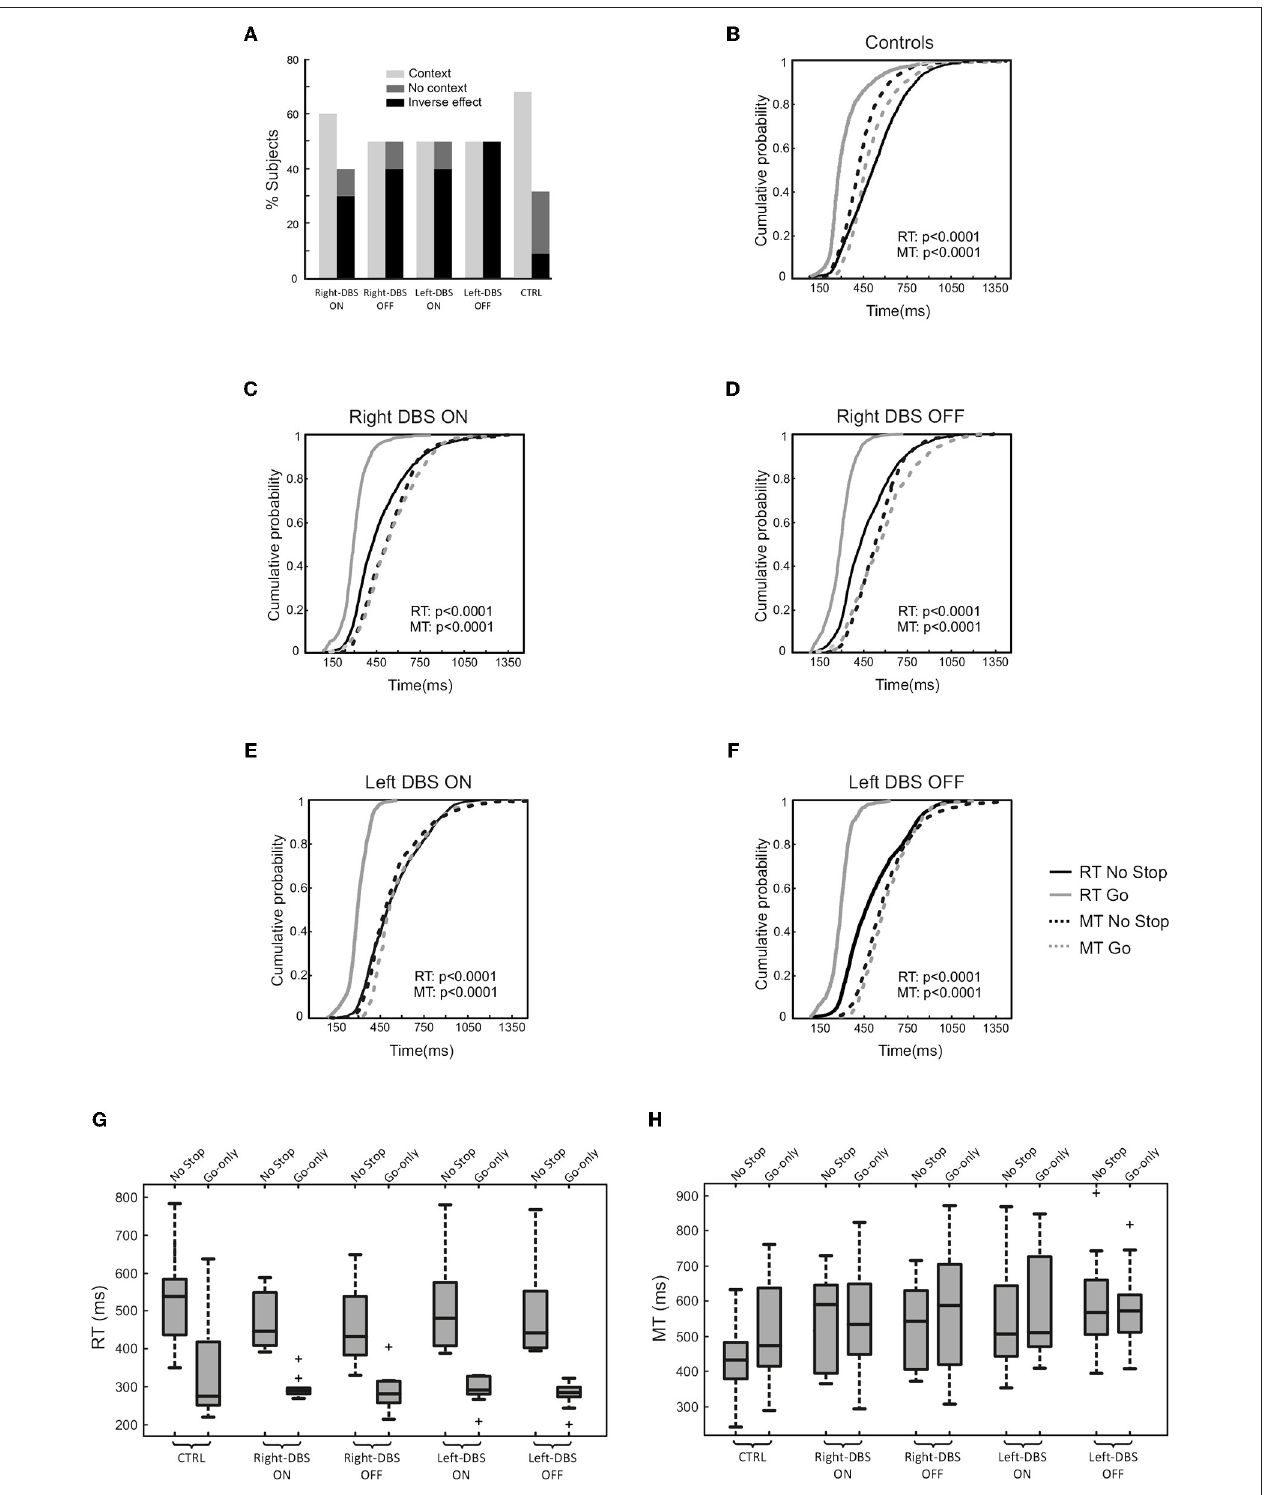
FIGURE 4 | Proactive inhibitory control in age-matched controls ( n = 22), right-DBS-ON and -OFF patients ( n = 10), left-DBS-ON and -OFF patients ( n = 10). (A) Percentage of right-DBS-ON and –OFF, left-DBS-ON and -OFF, and age-matched controls showing either (i) the context effect, i.e., the simultaneous significant increase in reaction times (RTs) and significant decrease in movement times (MTs) in no-stop trials with respect to go-only trials, (ii) the absence of a context effect